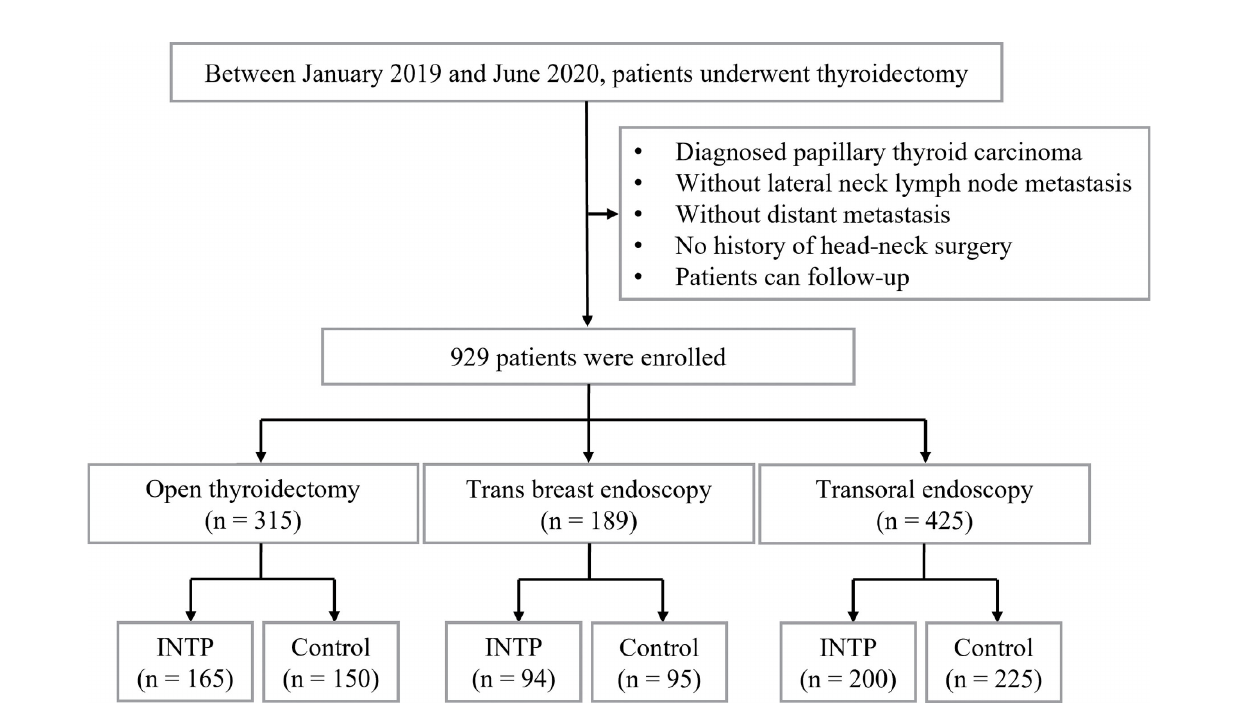
FIGURE 1 | Study fl owchart: enrollment and group assignment of the retrospective